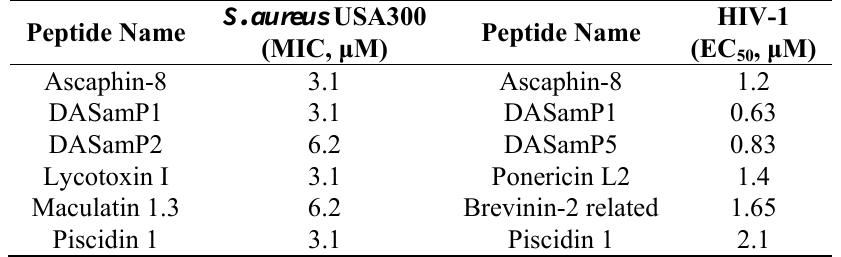
Table 2. Top six potent antimicrobial peptides against Staphylococcus aureus USA300 LAC or HIV-1 identified from database screening 1